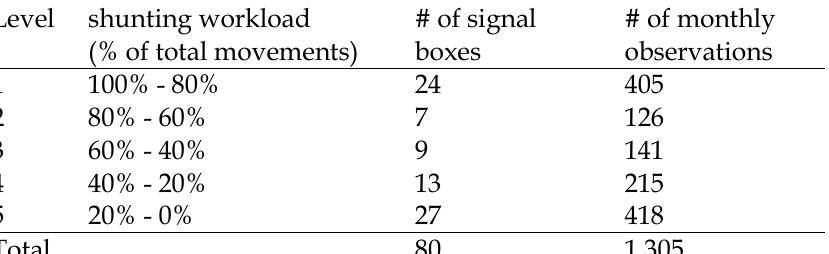
Table 1. Shunting levels (categorical variable SHUNT)